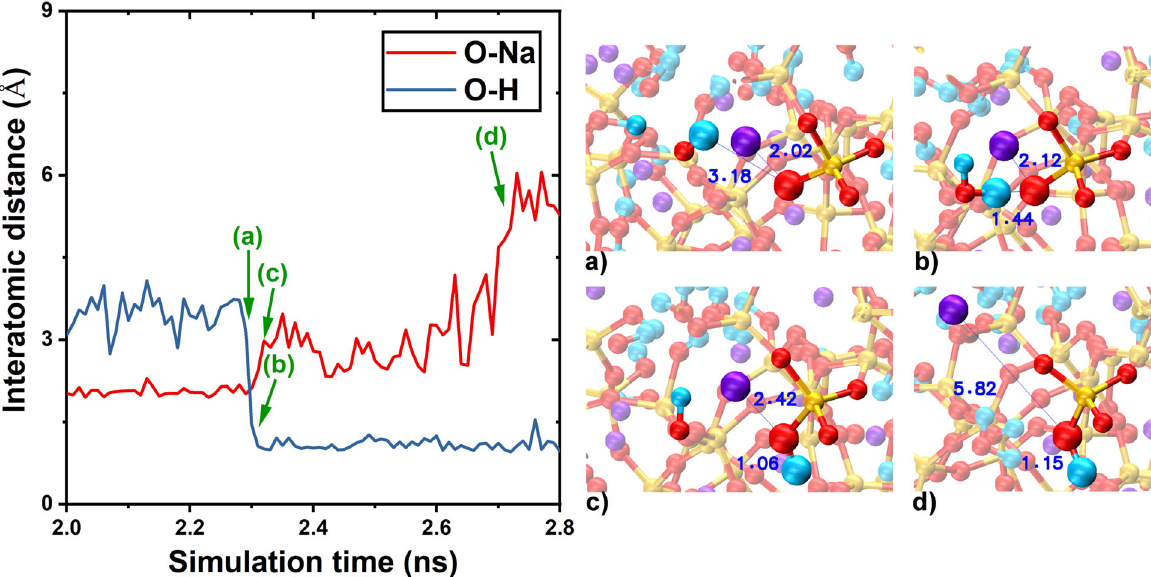
Fig. 3 Ion exchange that results in silanol formation on glass surface. Left is the distance of O – Na and O – H as a function of time, and right is the four con fi gurations ( a – d ) at stages of the ion-exchange